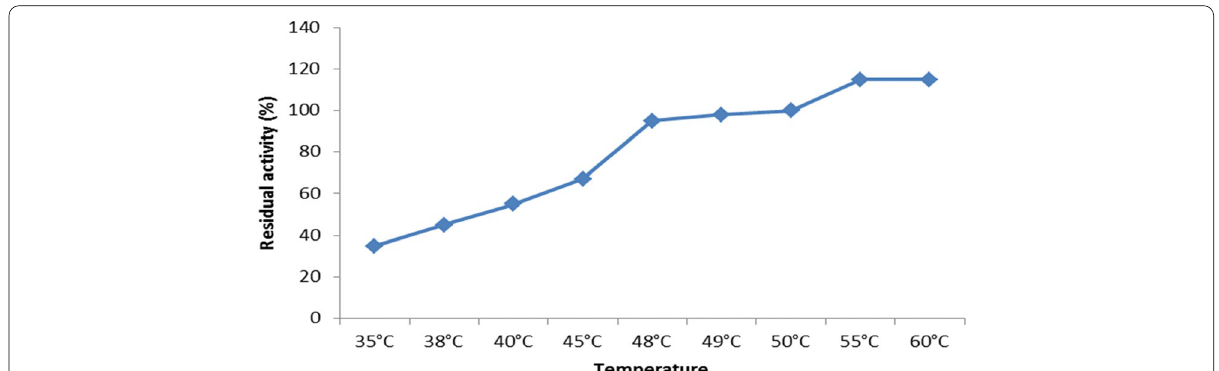
Fig. 8 Effect of temperature of the reaction on the activity of A. terreus strain RGS. Eg‑NRC xylanase. At varied temperatures, reactions with 1% (w/v) xylan were carried out at pH 6, 50 °C